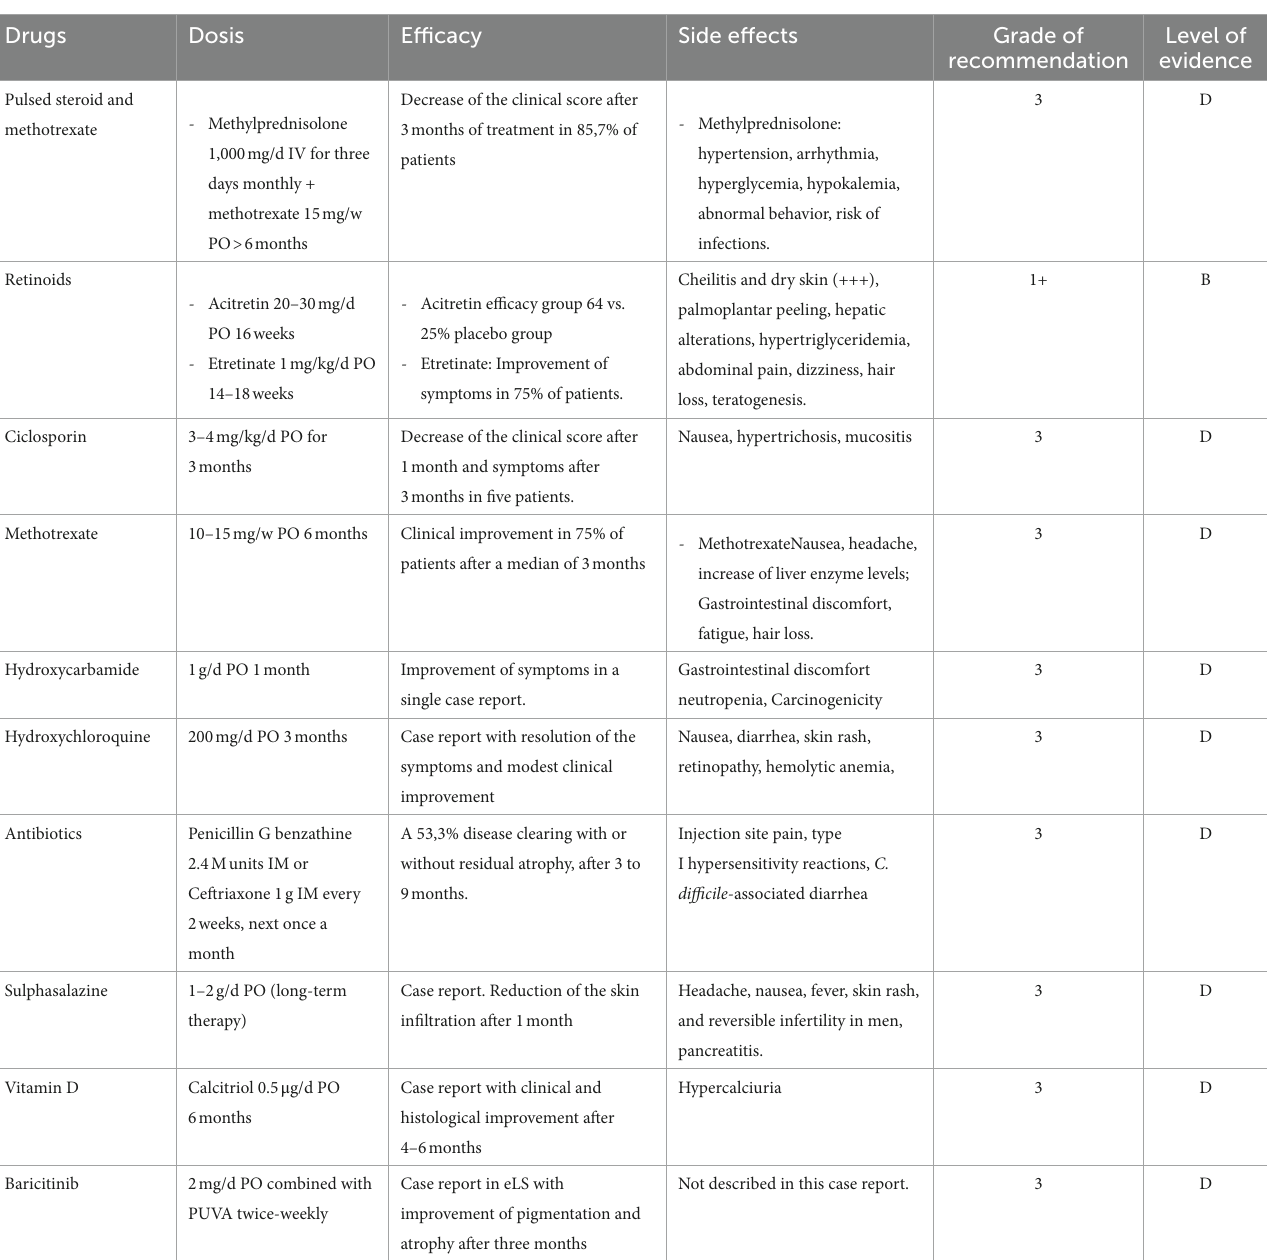
TABLE 9 Summary of effective systemic therapies in recalcitrant lichen sclerosus